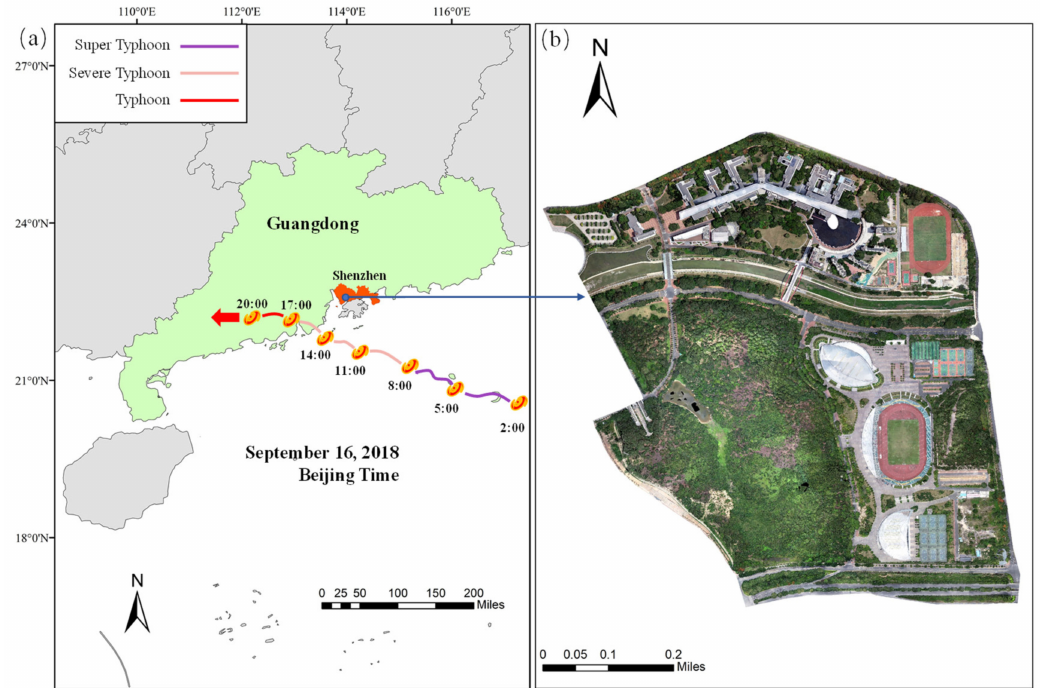
Figure 1. Study site. ( a ) Shenzhen city in Guangdong province, China, and the route of the super typhoon Mangkhut across Guangdong province. ( b ) Orthophoto map of the study area (GSD: 10